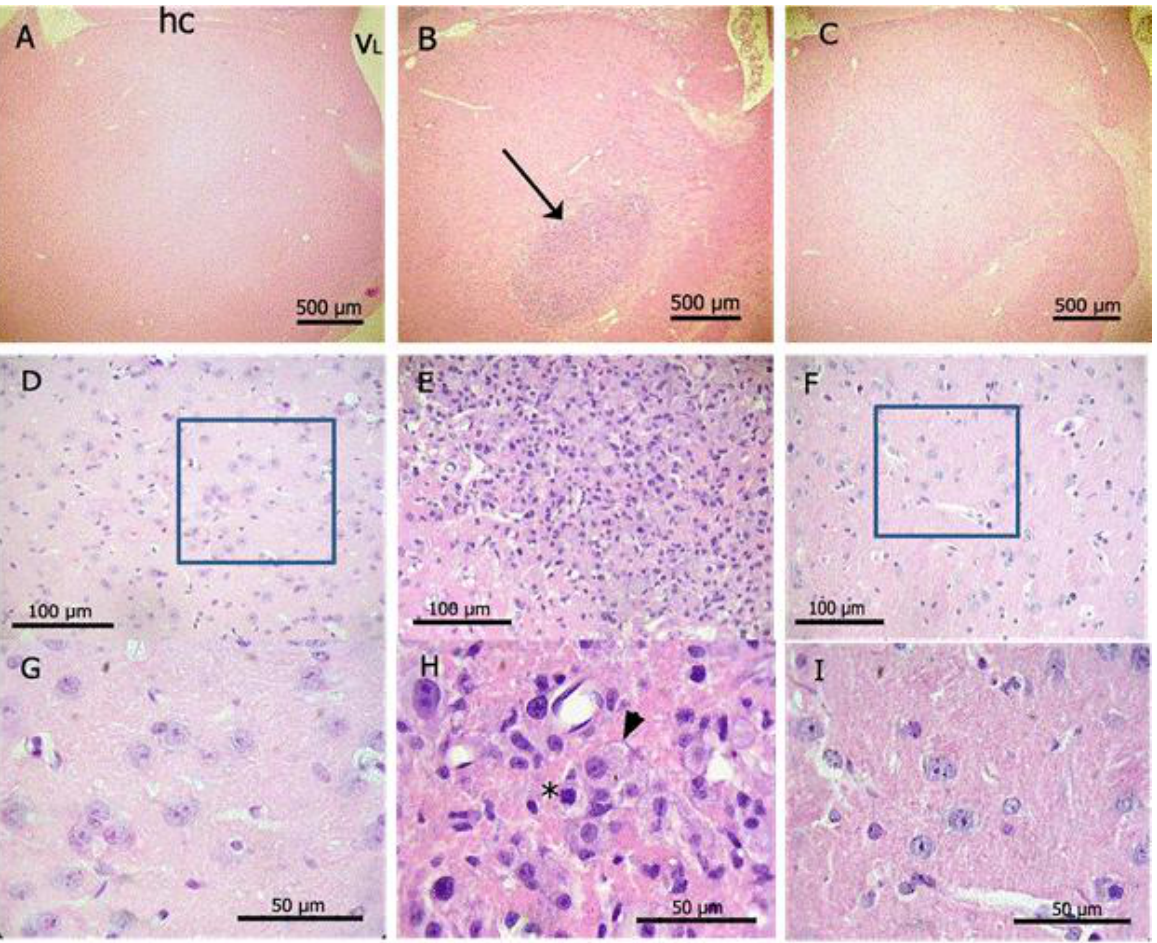
FIGURE 5 . H-E. (A) Control panoramic view of ipsilateral thalamus. VL: lateral ventricle; hc: hippocampus. (B) Unilateral ischemia producing big quantities of macrophages in nuclei of the thalamus. Arrow: macrophages. (C) Diminished damage in thalamus with Neuro-EPO IN . (D) Control ipsilateral thalamus (lower magnification). (E) Macrophage nuclei are shown. (F) Aspect similar to the control. (G) Control ipsilateral thalamus (higher magnification). (H) Macrophage with cytoplasm vacuolado (arrow head); macrophage in mitosis (asterisk). (I) Aspect similar to the control.